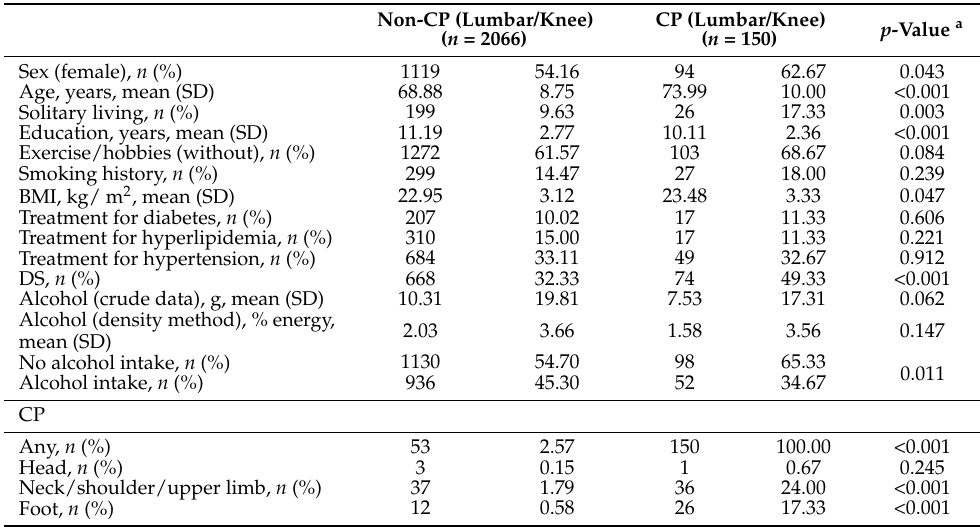
Table 3. Characteristics of body weight and GDS according to